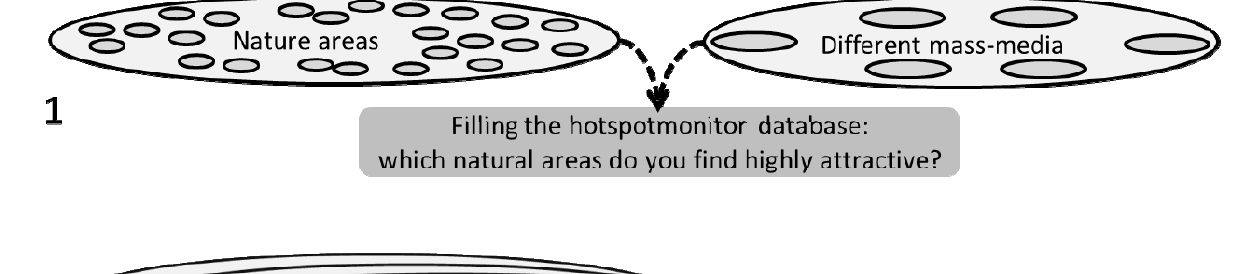
Figure 6. Research design of the project “Sympathy for the